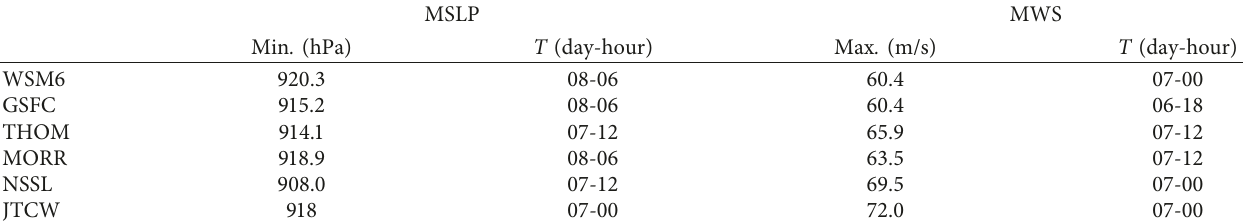
Table 2: Statistics of minimum sea level pressure (MSLP) and maximum surface wind speed (MWS) from the simulation using five MPSs, combined with JTWC for the supertyphoon Neoguri occurring in July